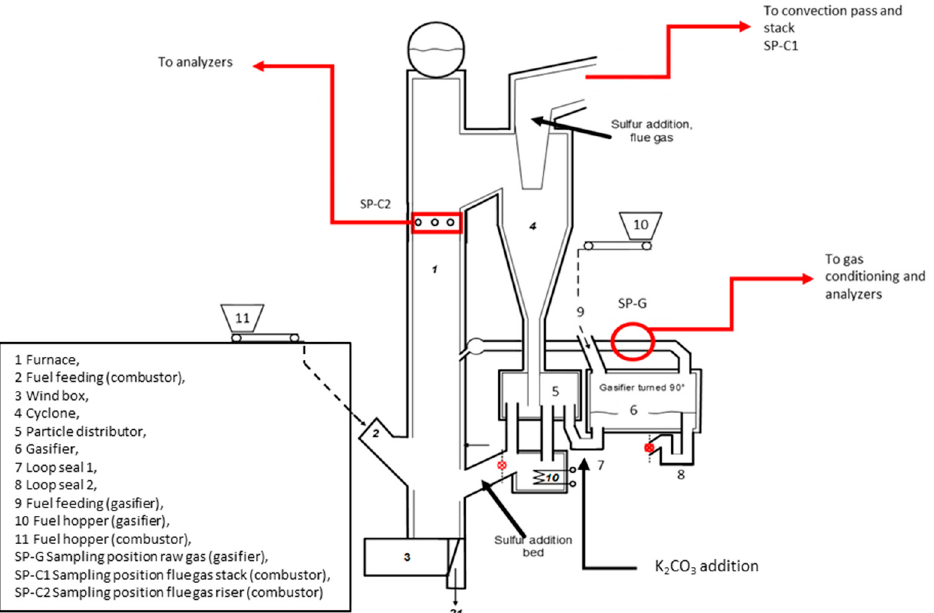
Figure 2. Schematic of the Chalmers DFB system, indicating the feeding scheme, the position for addition of S, and the gas sampling points. addition of S, and the gas sampling